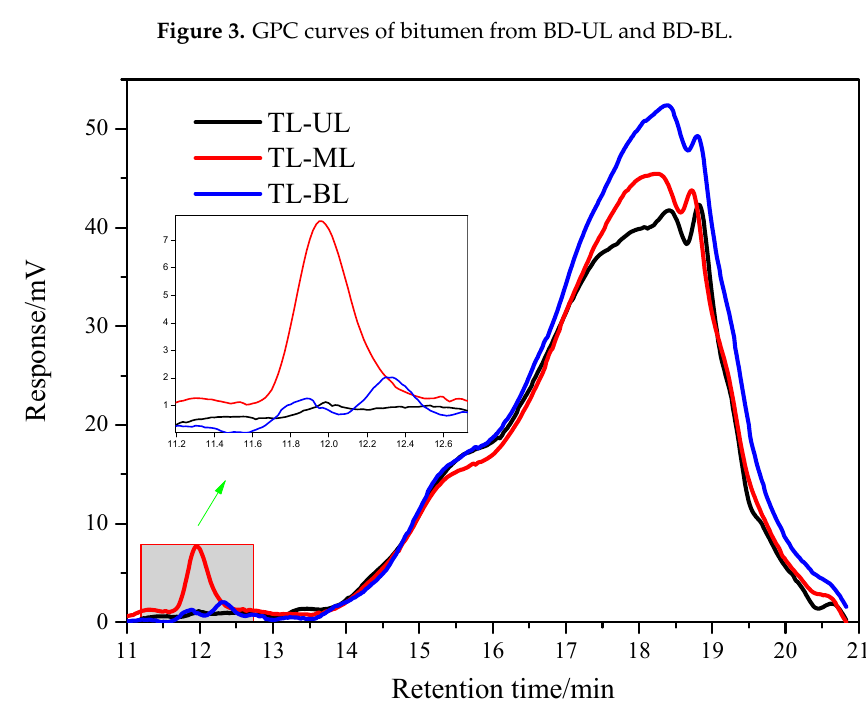
Figure 3. GPC curves of bitumen from BD-UL and BD-BL. 132